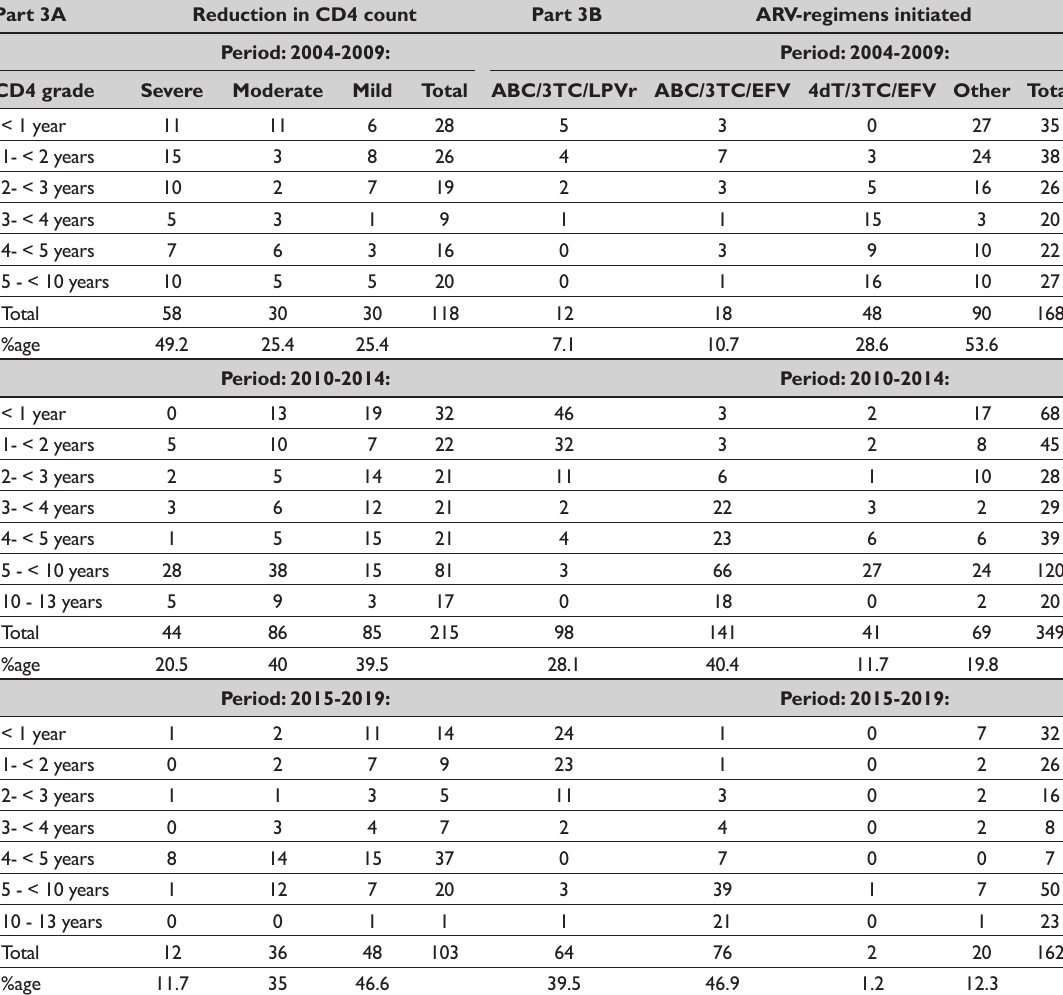
Table 3: The number of patients by age group and CD4 count (Part 3A) who were initiated on the different ARV regimens (Part 3B) in each policy